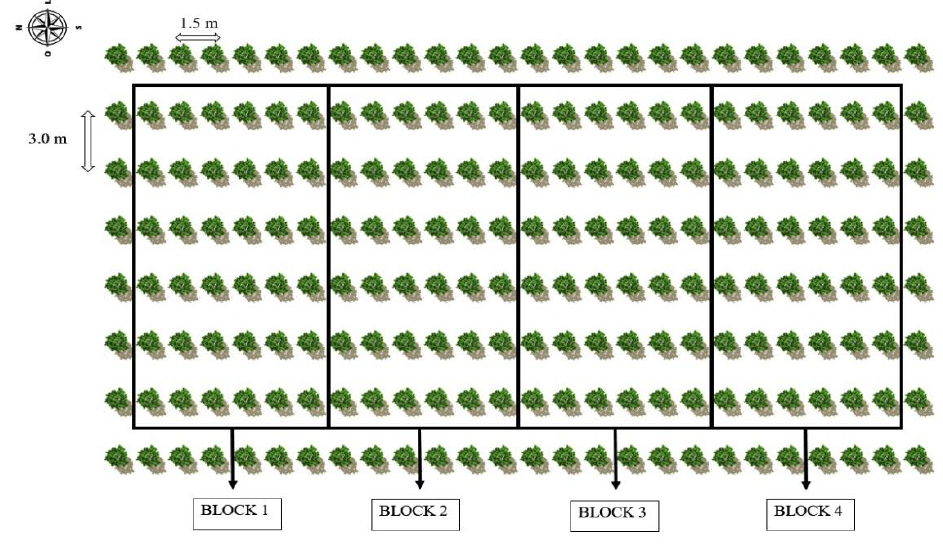
Figure 7. Layout of the experimental area.